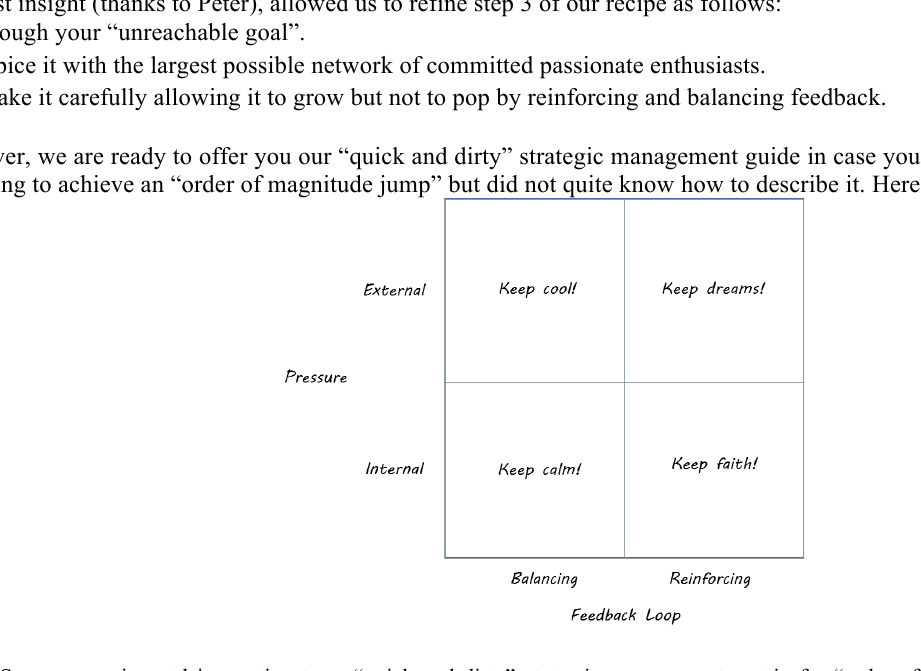
Fig. 3. IdeaSquare experimental innovation team “quick and dirty” strategic management matrix for “order of magnitude jumps”